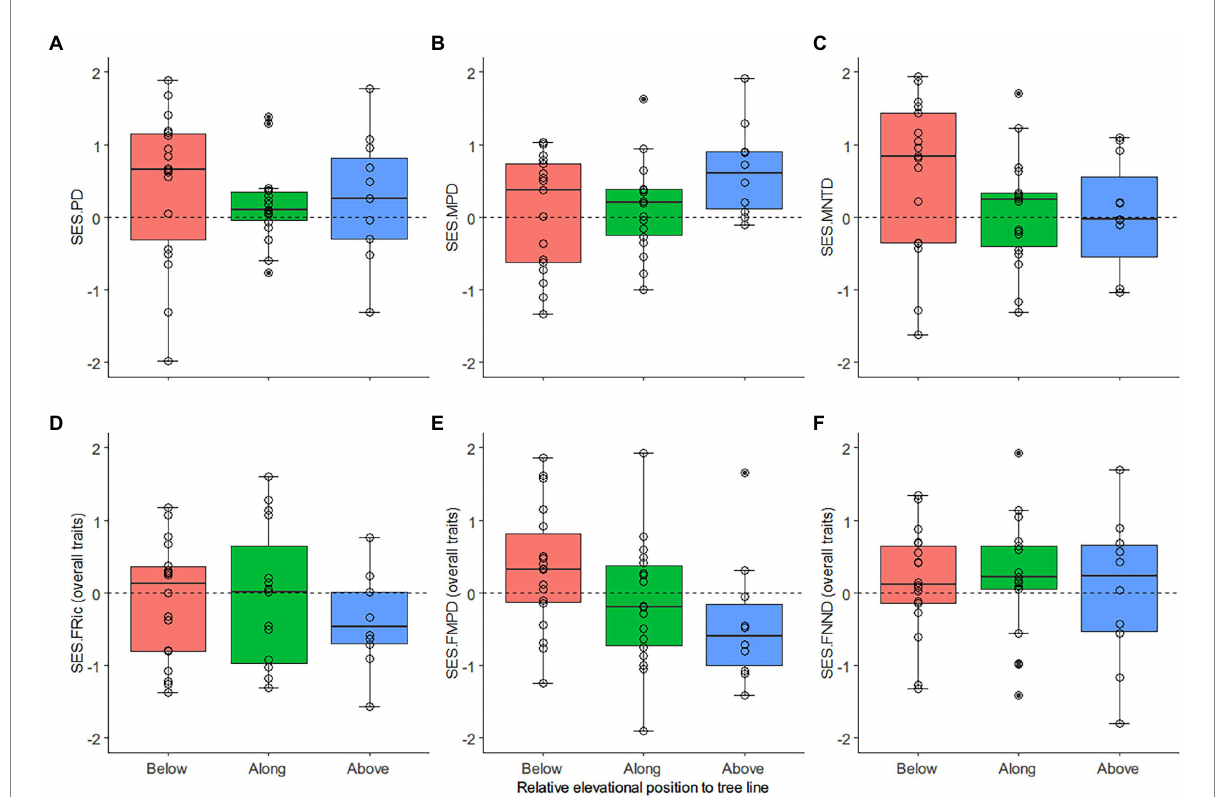
FIGURE 3 Distribution patterns of the standardized effect size (SES) of diversity metrics derived from phylogeny and overall traits. (A) phylogenetic richness (Faith’s index, PD), (B) average phylogenetic differences between all species pairs—mean pairwise distance (MPD), (C) average phylogenetic differences between closely related species pairs—mean nearest taxon distance (MNTD) and (D) functional richness (FRic), measured as the minimum convex hull volume, (E) average trait difference between all species pairs—functional mean pairwise distance (FMPD), (F) average trait difference between similar species pairs—functional mean nearest neighbor distance (FNND). The X-axes mark transects from low (below the tree line) to high (above the tree line) elevation. The circles mark the SES values of the transects. The boxplot summarizes values for each transect position: the horizontal solid line inside the box indicates the median, the box height represents values ranging from 25% to 75% percentile (the middle 50% of scores), the upper and lower whiskers represent scores outside the middle 50%, and the dots mark the